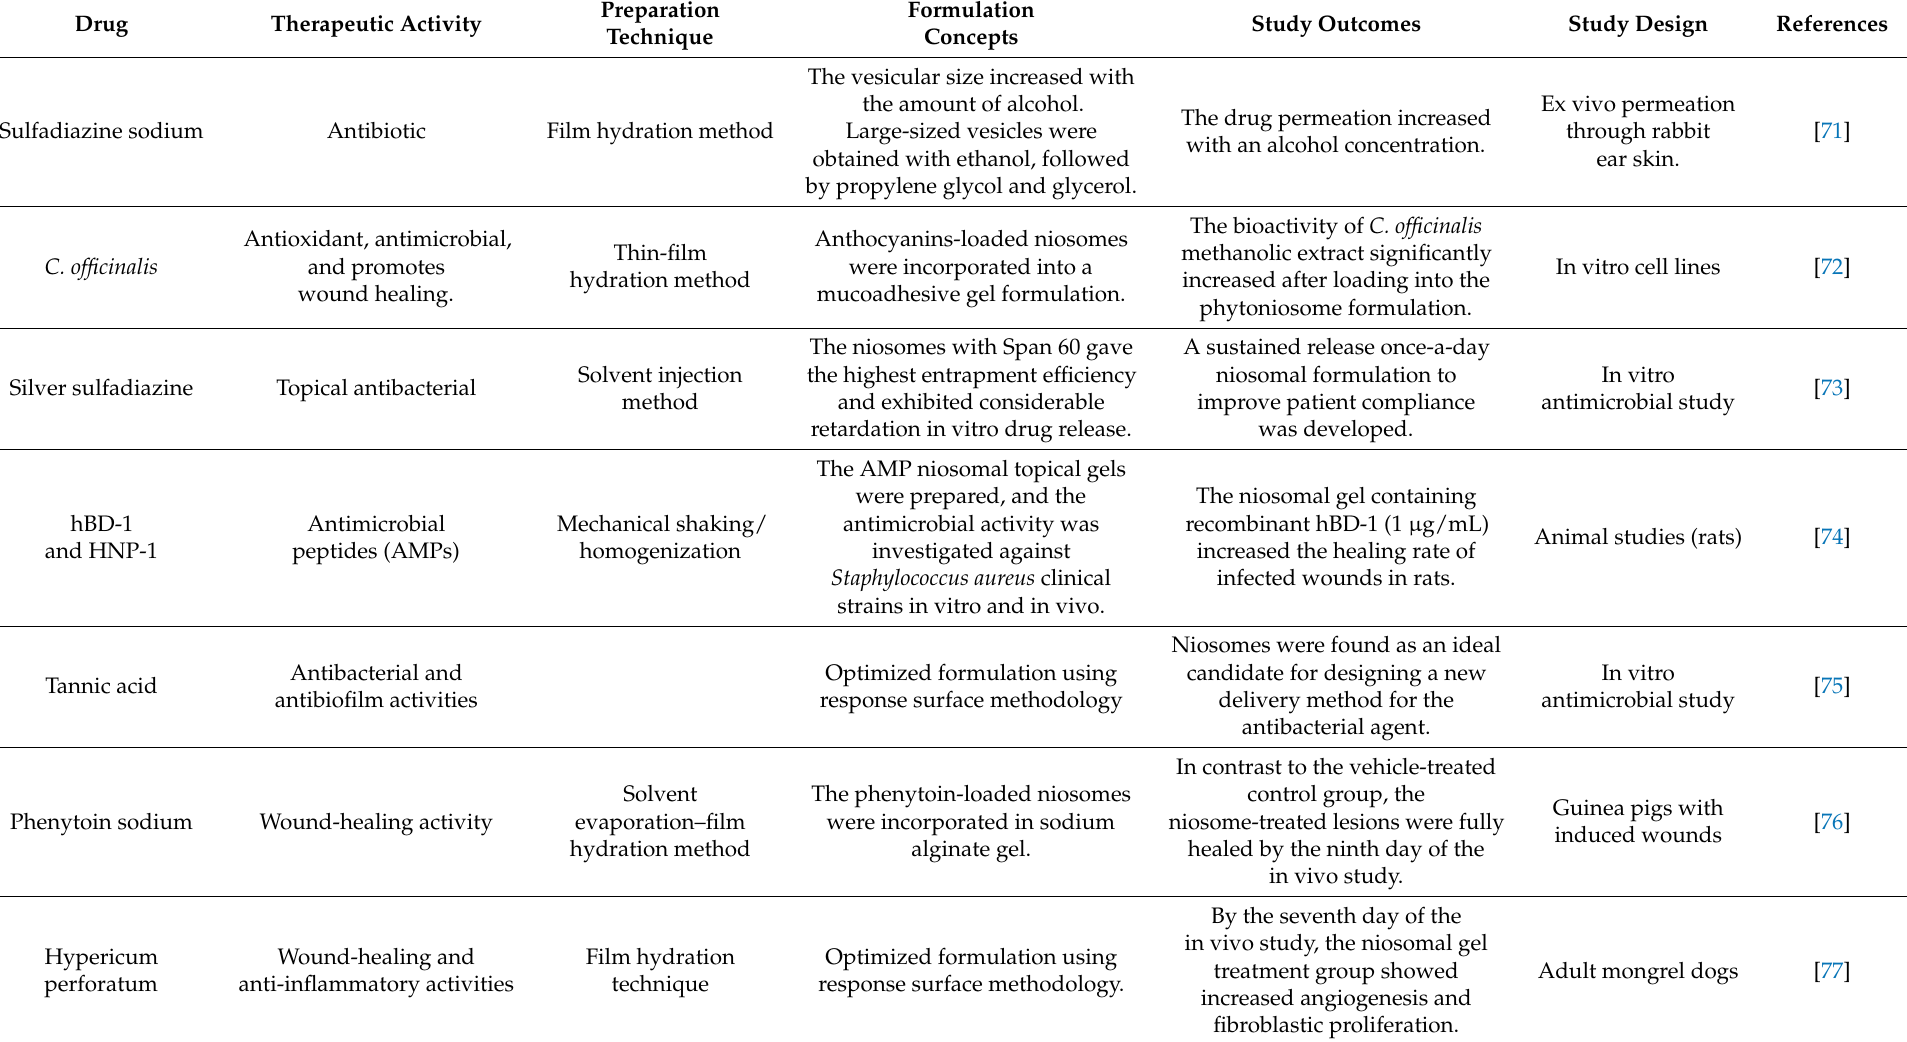
Table 6. Characteristics and outcomes of niosomal formulations in burn